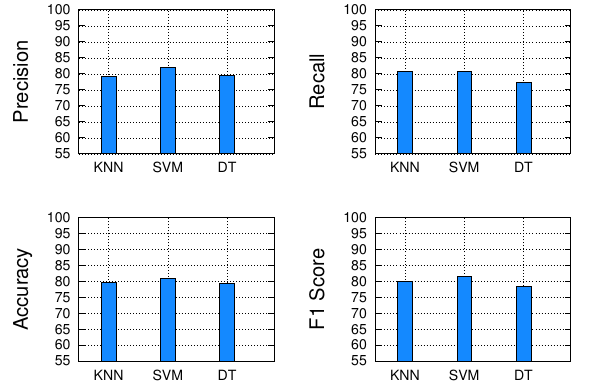
Figure 4. Performance measures for the Darkness malware family with network artifact classification using Chatter atop a baseline classifier